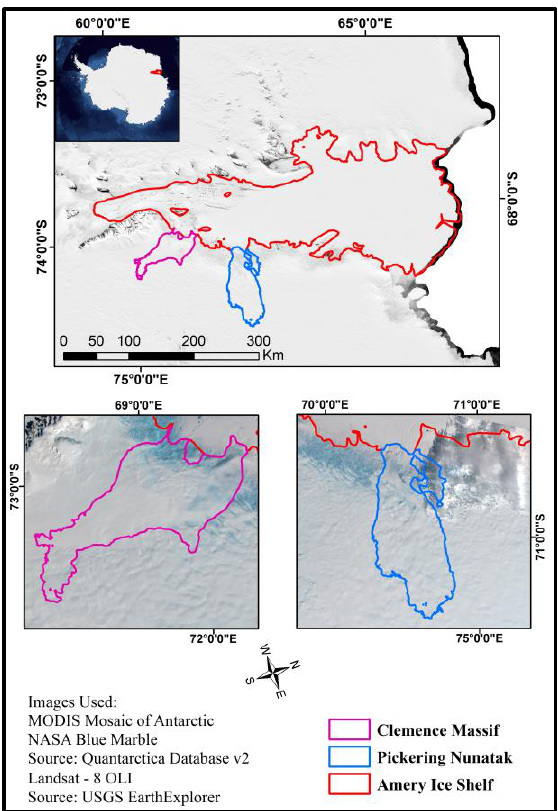
Figure 1. Geographical location of the study area.